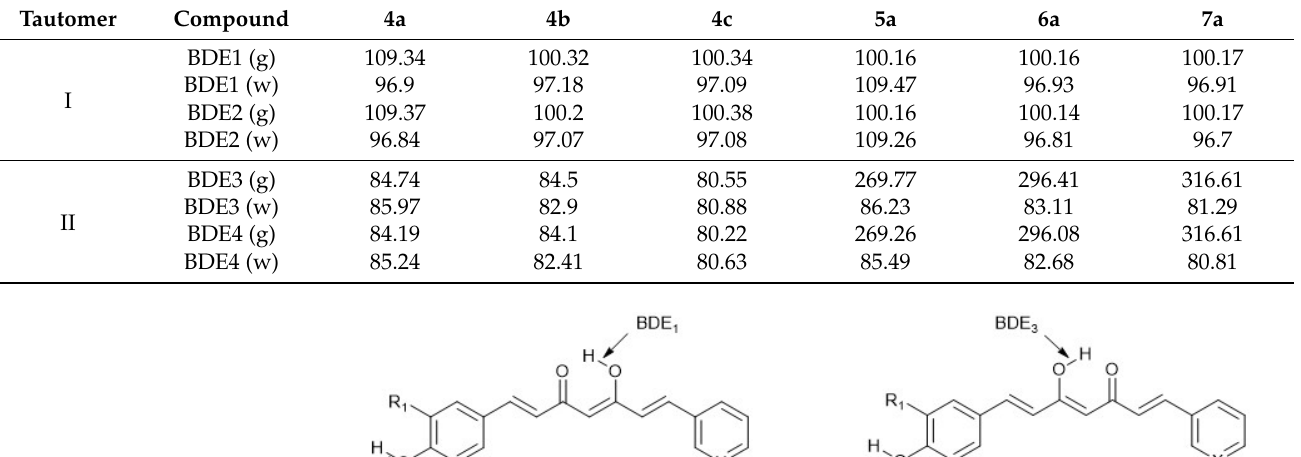
Table 4. Bond dissociation enthalpies (kcal/mol) for hydroxyls in compounds, both in gas phase (g) and water as solvent (w).